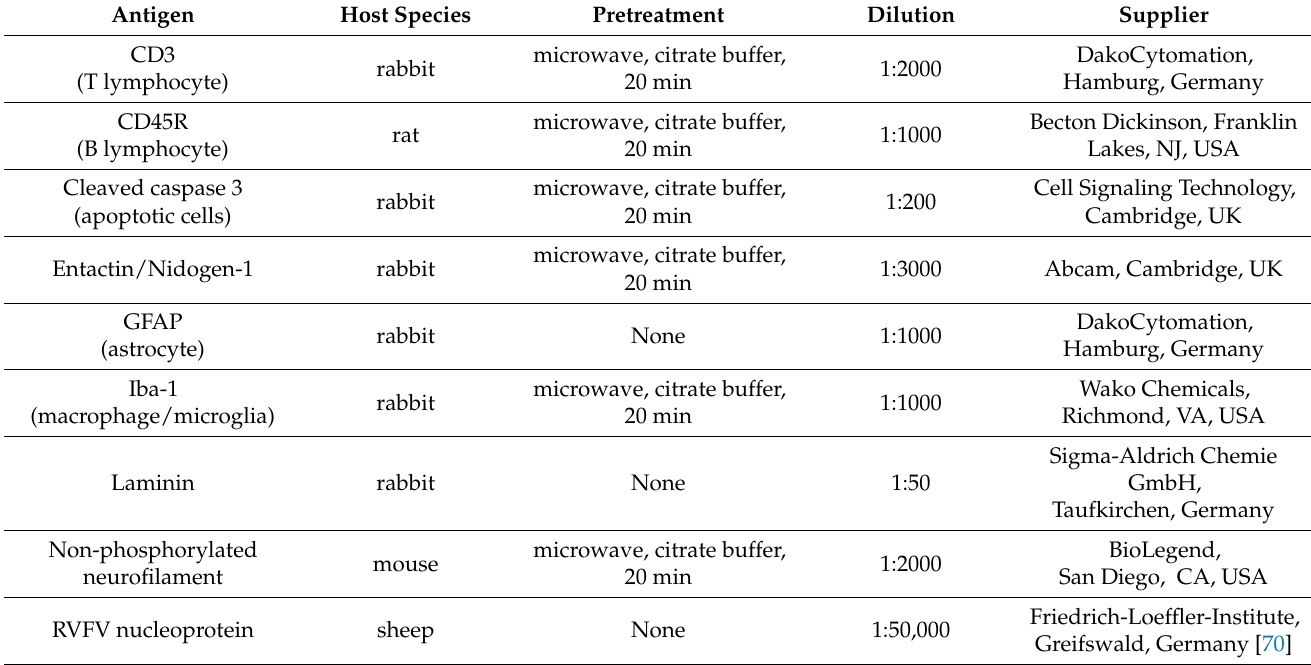
Table 2. Primary antibodies used for